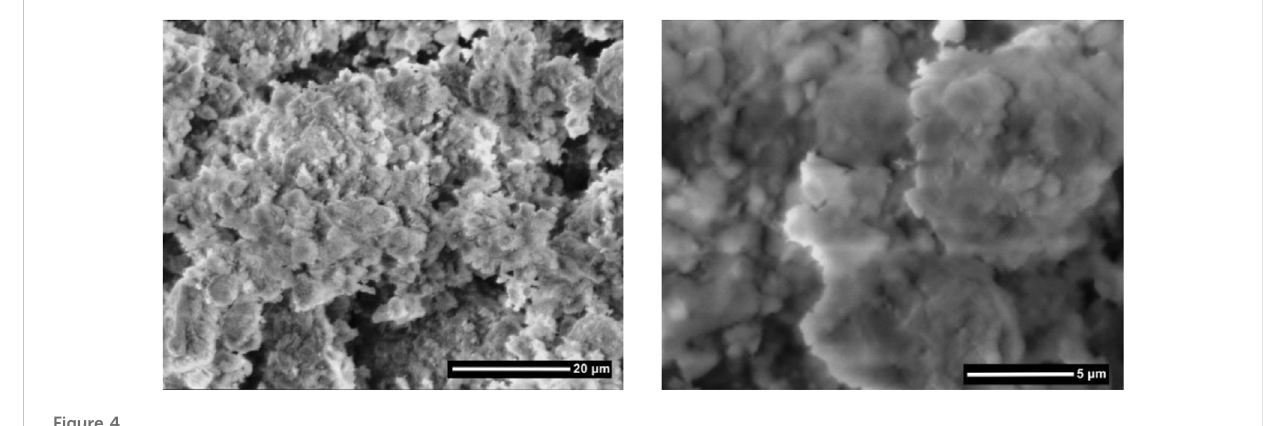
Figure 4 The SEM images of clay sample.